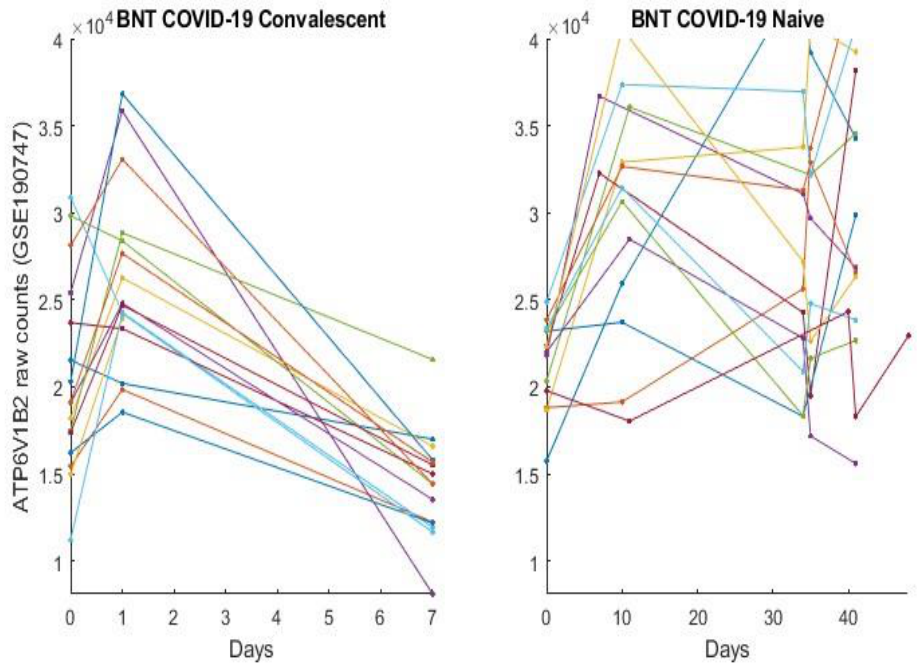
Figure 6. ATP6V1B2 expression responses to BNT162b2 vaccines: The left panel is for COVID-19-recovered octogenarians; the right panel is for COVID-19-naïve individuals. Each color line corresponds to one patient’s records.